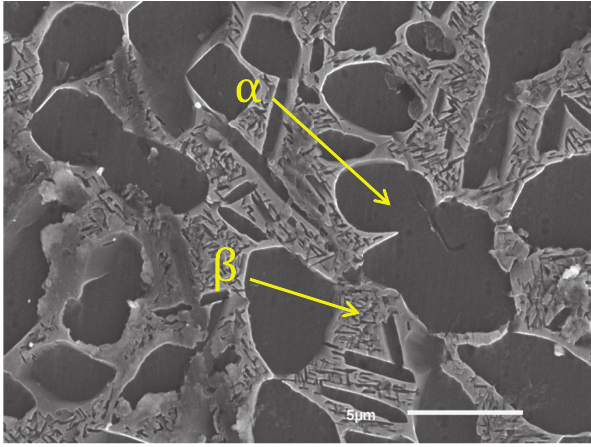
Figure 2: Ti-17 titanium alloy